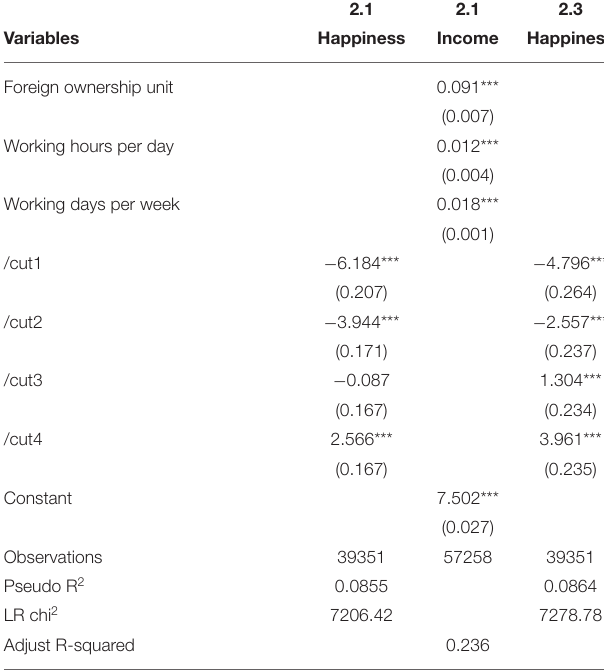
TABLE 3 | Regression results of restricted working time